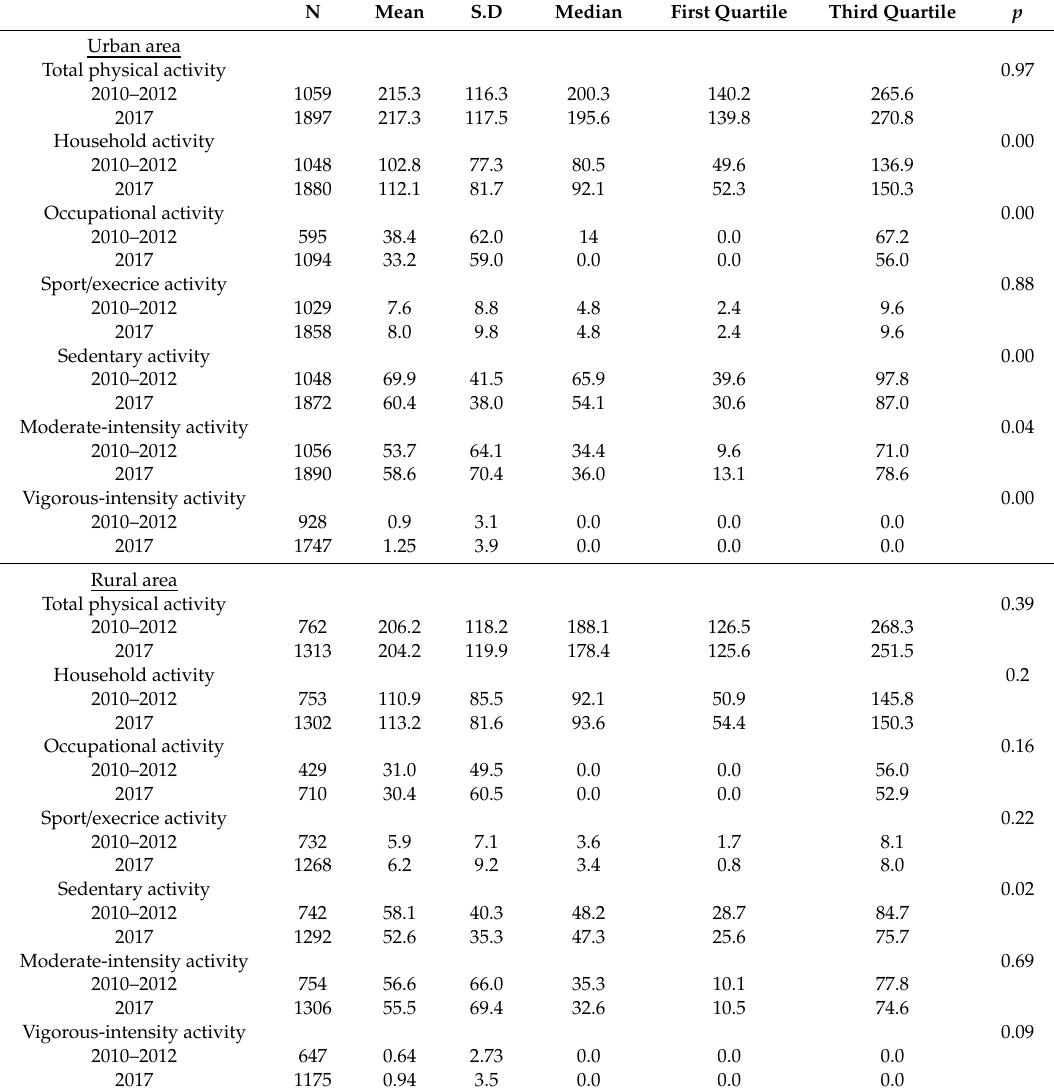
Table 3. Physical activity of women during pregnancy living in rural and urban areas in Poland in the years 2010–2012 and 2017. N Mean S.D Median First Quartile